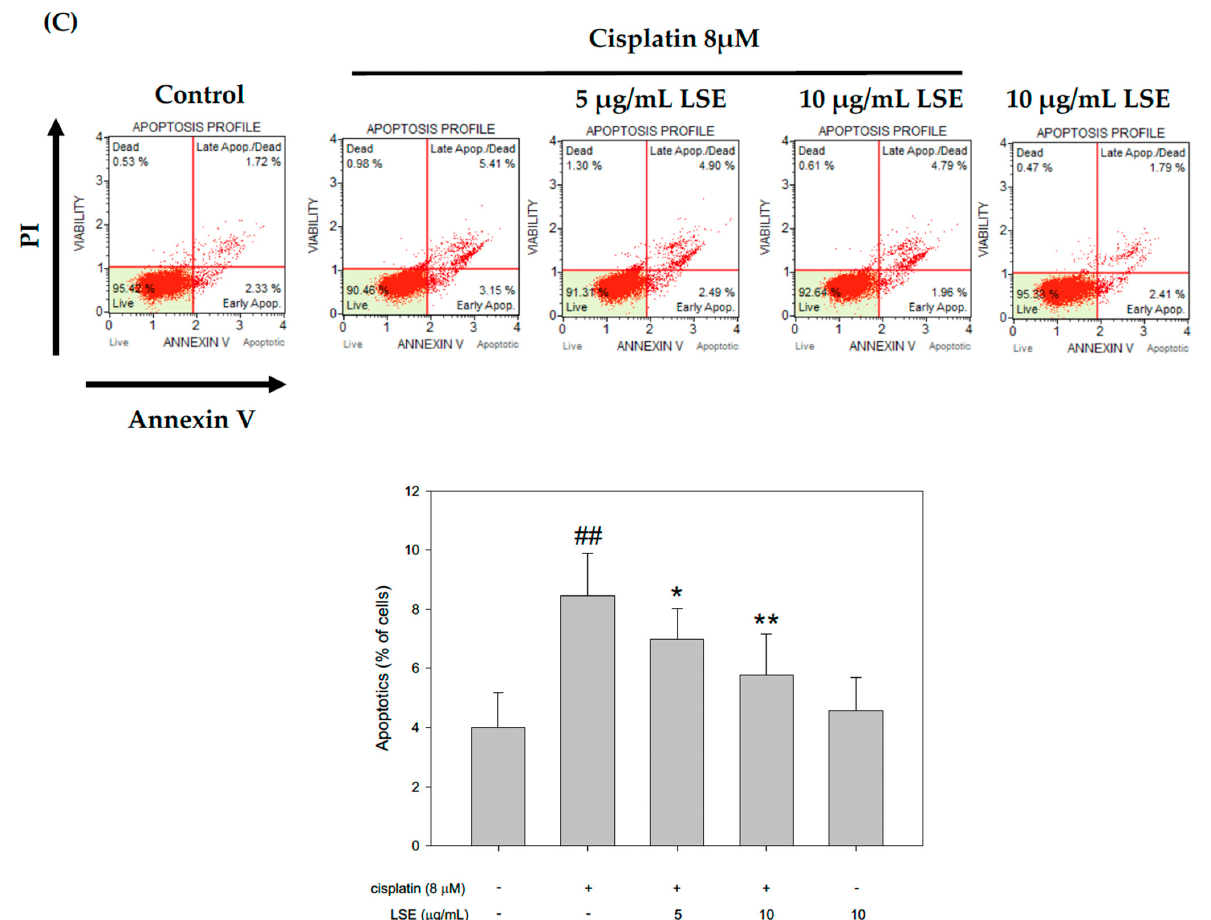
Figure 3. Effect of LSE on cisplatin-induced apoptosis in NRK − 52E cells. NRK − 52E cells were treated with or without LSE (5, 10 µ g/mL) for 24 h in the presence or absence of cisplatin (8 µ M). ( A ) The depolarization was assayed by JC-1 staining with flow cytometry. ( B ) The apoptotic cells were assayed by DAPI staining and the DAPI-positive cells were presented as a percentage of the total number of cells. (C) The apoptotic cells were analyzed by flow cytometry and apoptotic values were the percentage of apoptotic cells divided by the total number of cells. Quantification data were presented as mean ± SD of three independent experiments by using Sigma plot 10.0 software. ## p < 0.01 compared with the control group; * p < 0.05 compared with the cisplatin group, ** p < 0.01 compared with the cisplatin group.